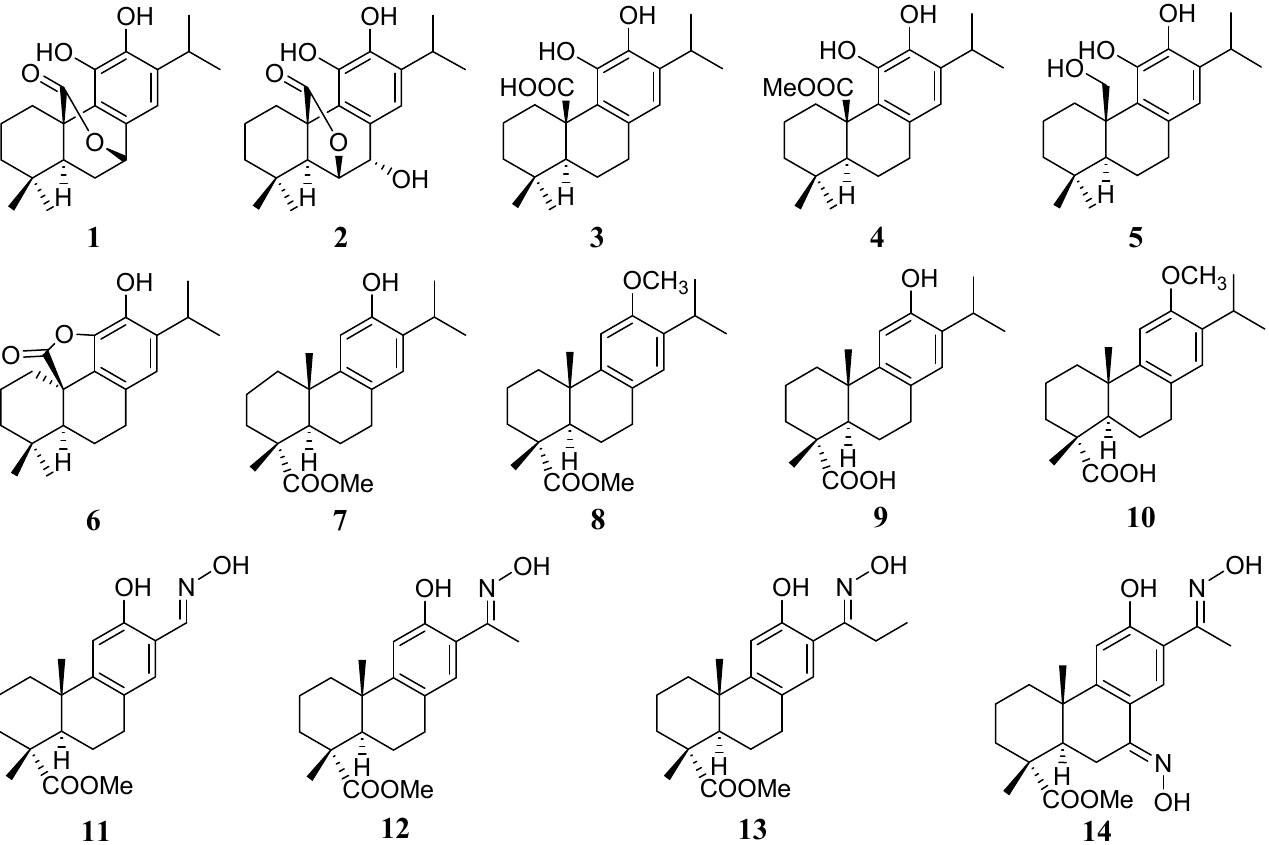
Figure 1. Chemical structures of the naturally occurring carnosol ( 1 ), rosmanol ( 2 ) and carnosic acid ( 3 ) as well as of the synthetic carnosic and dehydroabietic acid derivatives 4 – 14 .